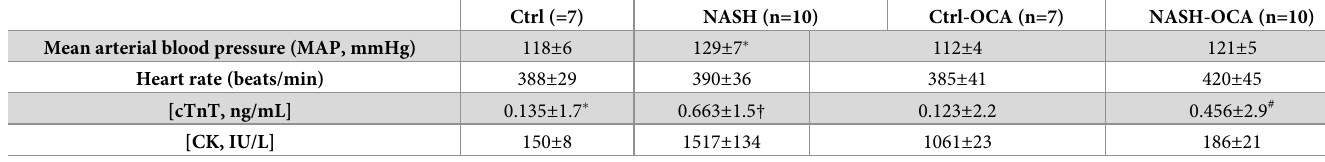
Table 1. Hemodynamic and cardiac injury parameters of mice in different groups.